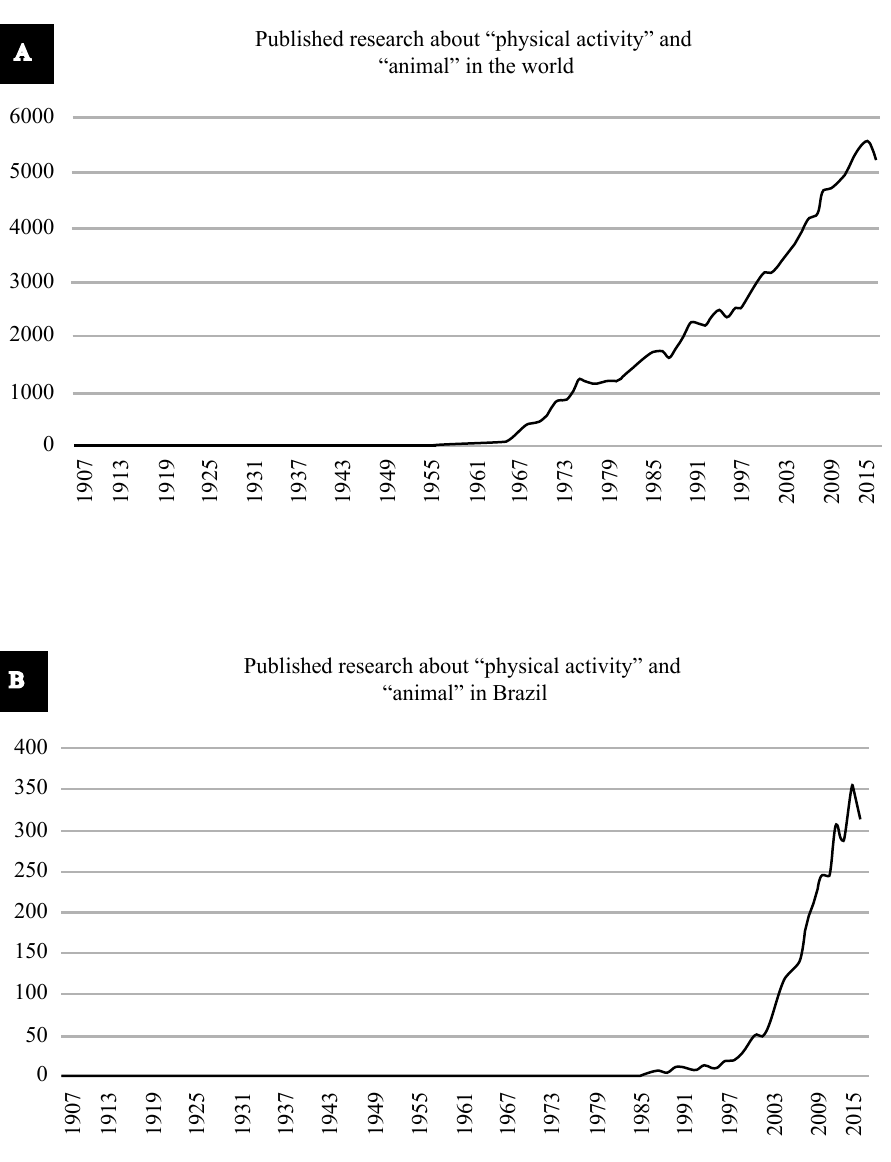
Figure 1. (A) Illustrates the increase (1907-2015) in the number of articles available at Medline using the keywords “Physical activity” and “ani - mal”, our search yielded 120,628 articles. (B) When the word “Brazil” was added in the survey, we obtained 2,993 articles in this period, i.e., nearly 2.5% of all articles found. Table 1. Search result aggregating the key-words: “physical activity”, “exercise” or “sport” with “animal”, “rat” or “mice” in “Brazil”.